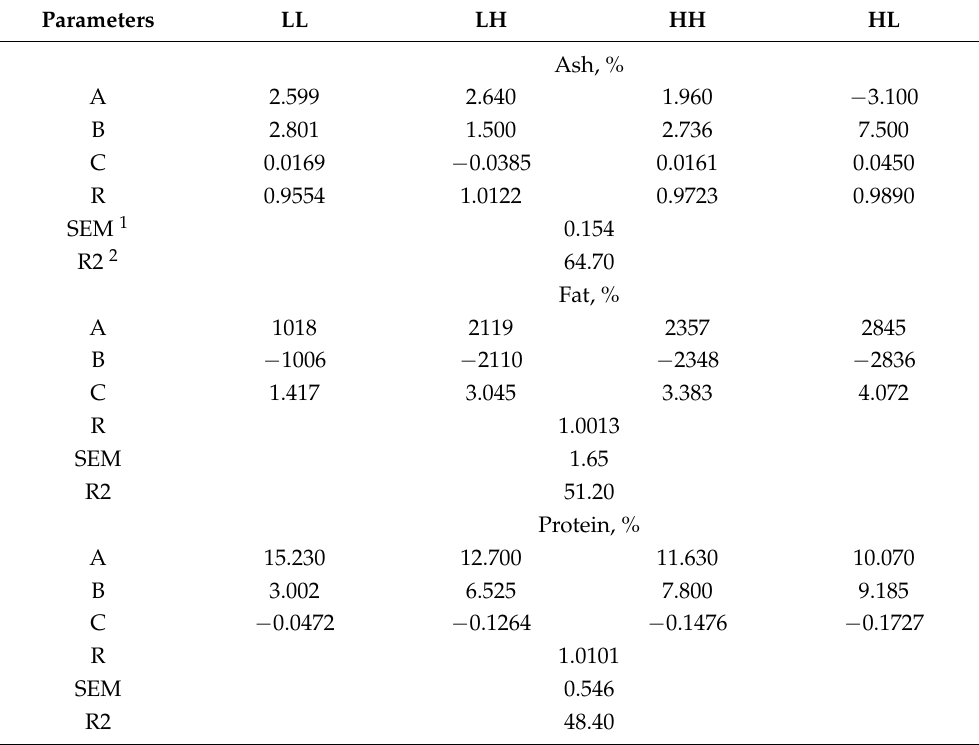
Table 7. Coefficients of exponential equation for body weight and body composition of laying hens from 19 to 102 weeks old consuming levels of dietary balanced protein (LL or HH), repleted (LH) and depleted feeds